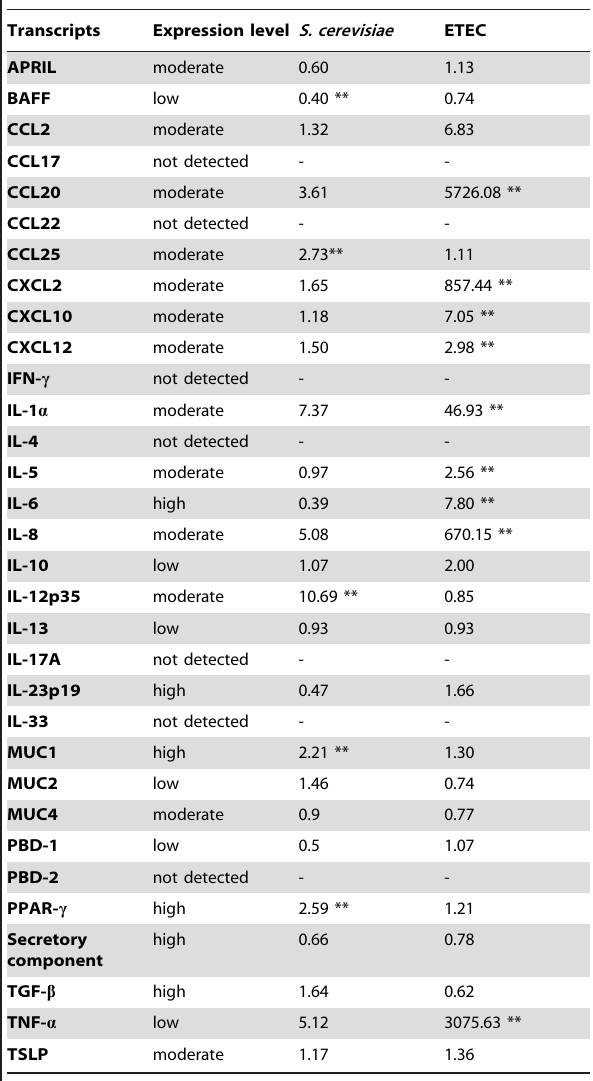
Level of mRNA expressions in untreated cells are expressed in the second column (high: Amplification around 17–24 cq ( cycle quantification ), moderate: Around 25–29 cq , low: Around 30–33 cq , not detected: More than 33 cq ).